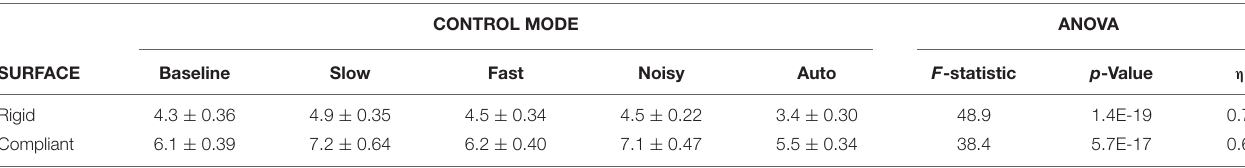
TABLE 3D | Mean performance (inverse force error, N − 1 ) across control modes on rigid and compliant surfaces.